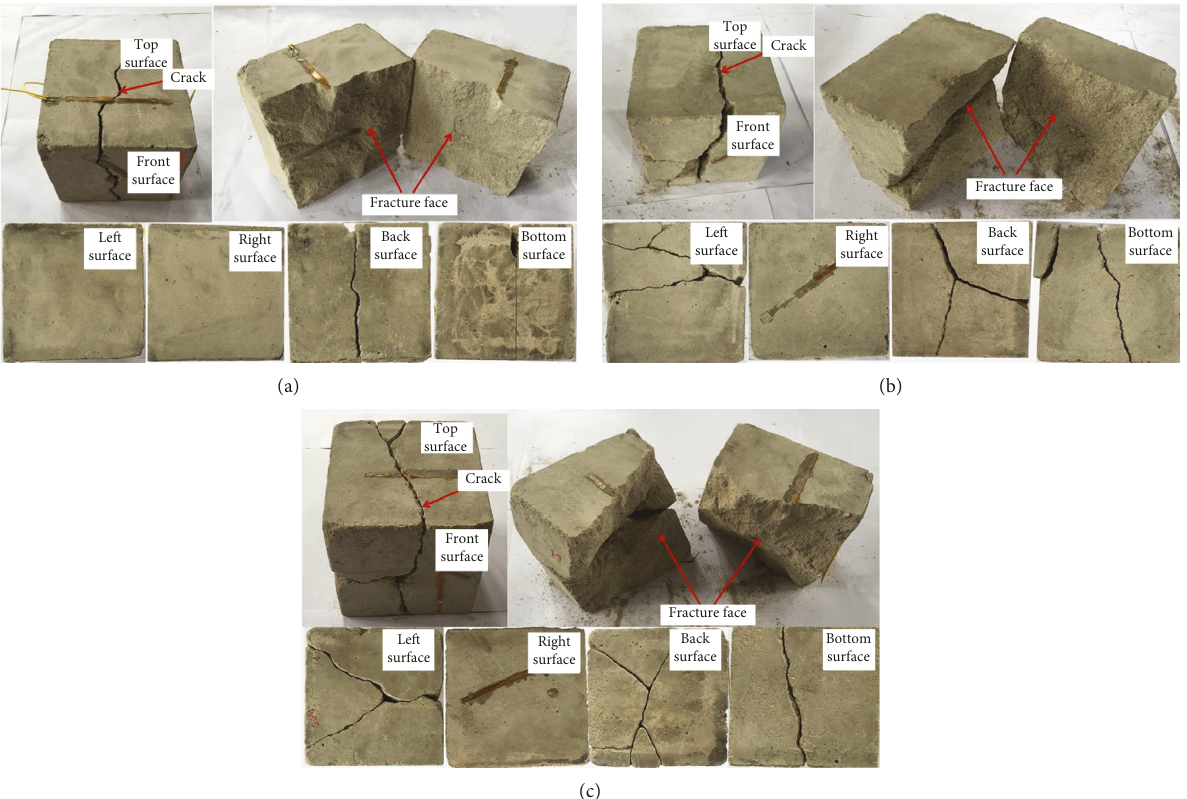
Figure 5: The macroscopic crack morphology on the experimental blocks’ surface under the designed condition of 1 L gas volume: (a) P � 5MPa, (b) P � 7 . 5MPa, and (c) P �